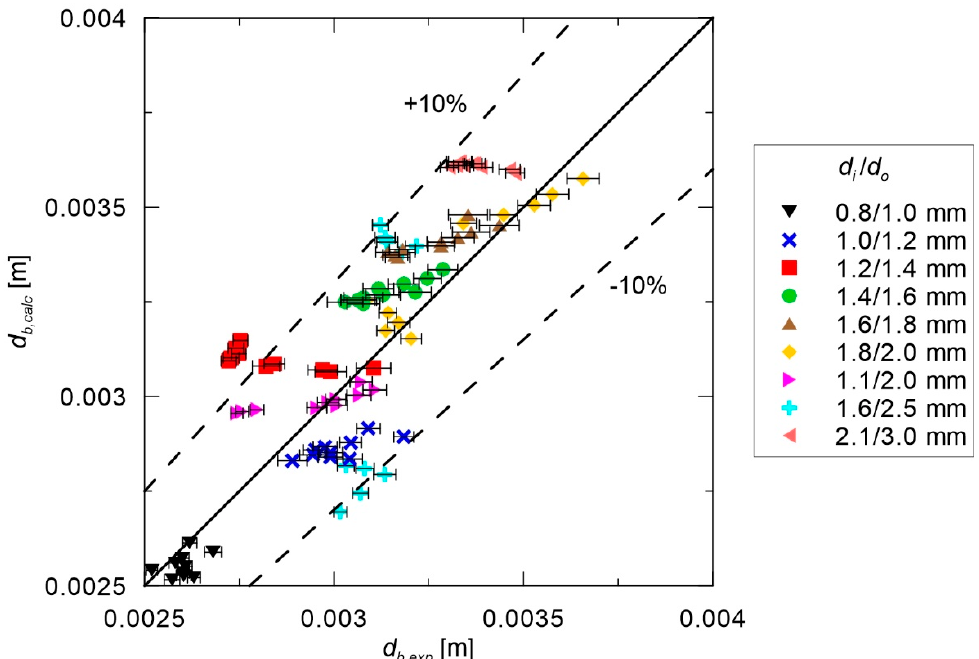
Figure 7. Comparison of experimental and calculated data, using Equation (40) bubble diameters.